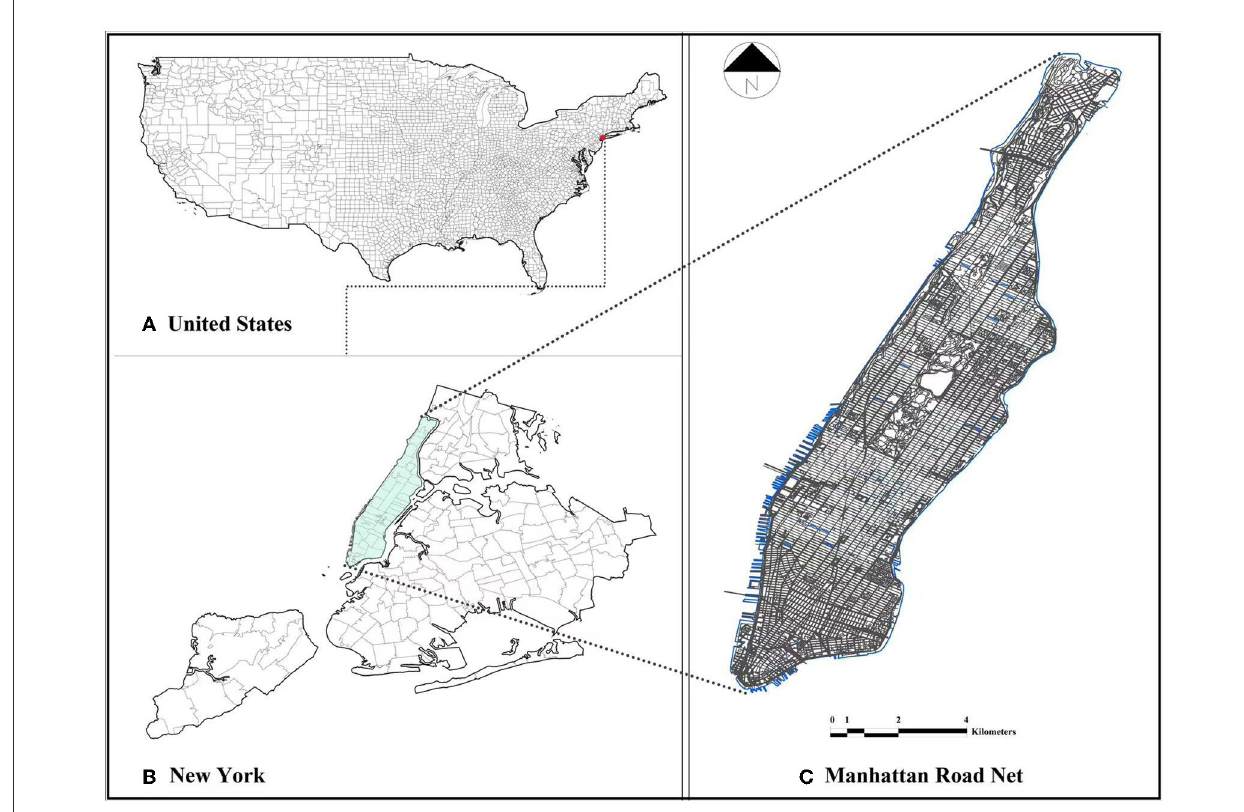
FIGURE1 Study area: (A) Map of the United States; (B) New York County; and (C) Manhattan road